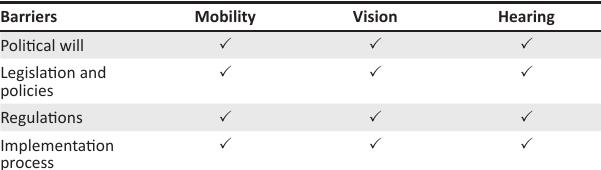
TABLE 6: Summary of institutional